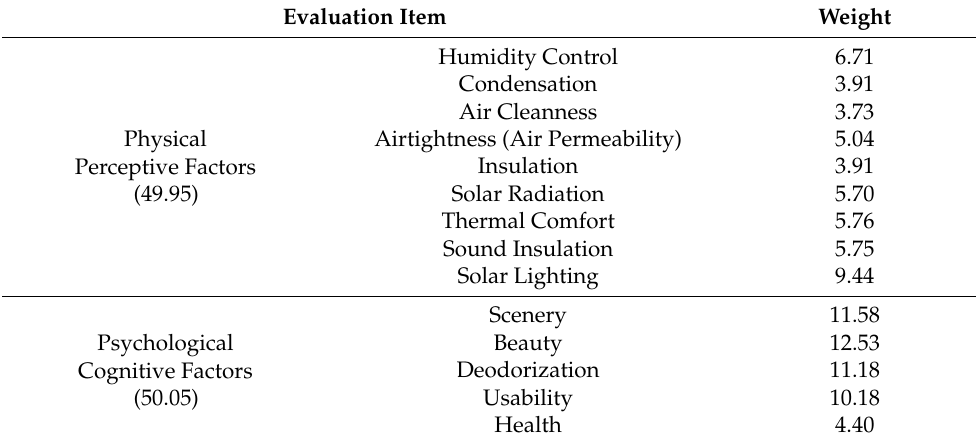
Table 2. Comfort performance item of the traditional hanok